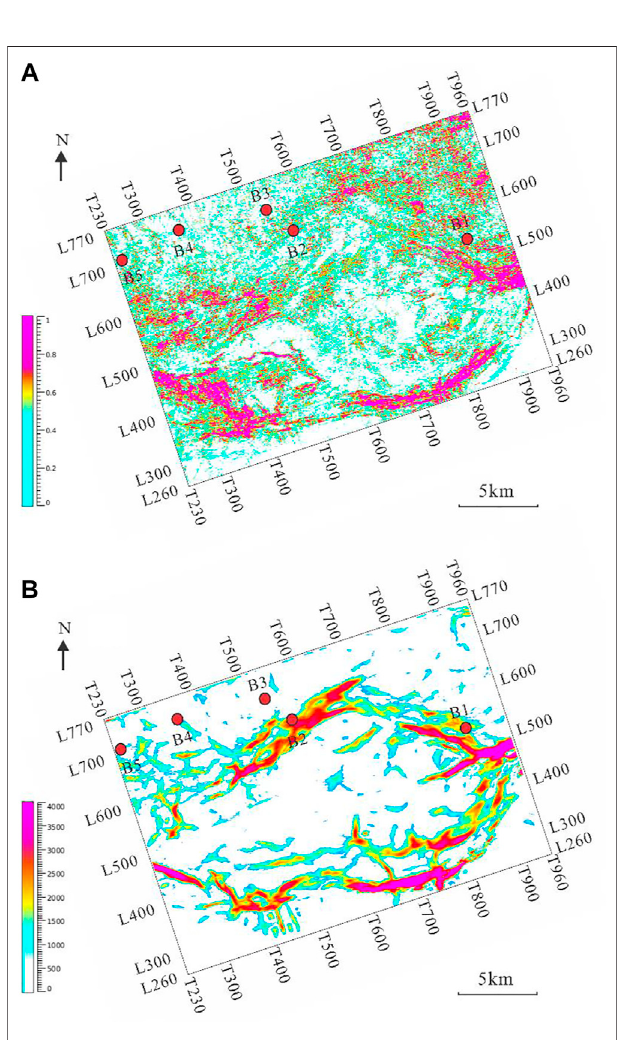
FIGURE 5 | Prediction plane of primary and secondary faults with post- stackcoherencepropertiesandcurvaturepropertiesoftheuppersweetspot. (A) Coherencepropertyplaneoftheuppersweetspot. (B) Curvatureproperty plane of the upper sweet spot.